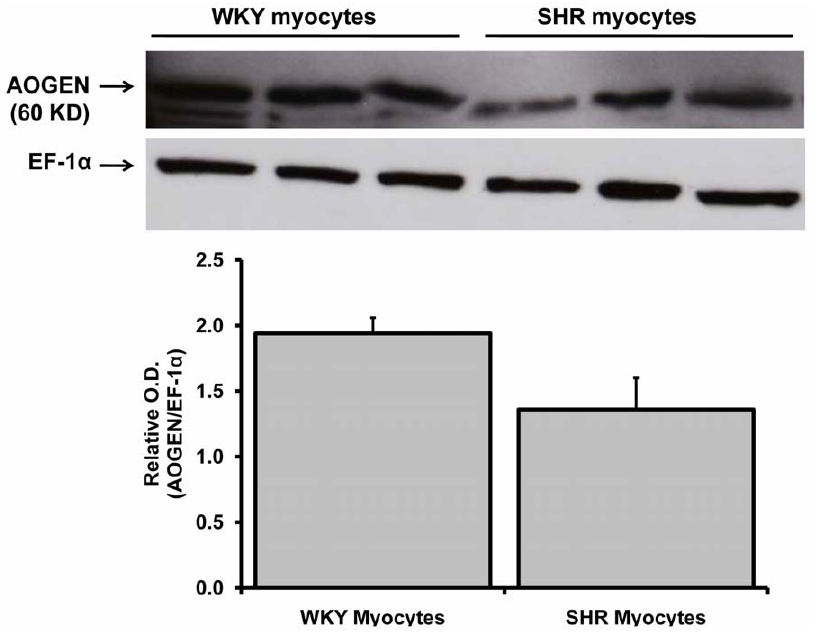
Figure 6. Angiotensinogen protein expression in WKY and SHR myocytes. Western blotting of angiotensinogen (AOGEN) protein expression in neonatal WKY and SHR myocytes (maintained for 48 hours in serum-deprived medium) by using an antibody directed against an epitope on the NH2-terminus region of the angiotensinogen protein (residues 44–56). The myocytes cell lysate (50 m g protein) were separated by gel electrophoresis and transferred on PVDF. Equal protein loading was confirmed by EF-1 a detection in cell lysates. Relative O.D. (AOGEN/EF-1 a ) is represented as the mean 6 SE of three samples from each group.